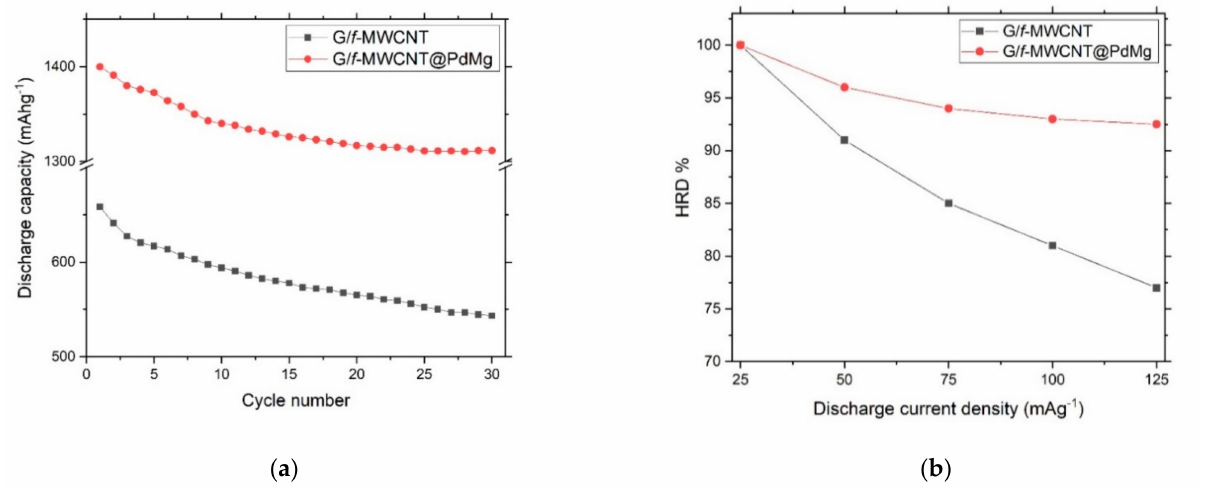
Figure 6. ( a ) Discharge capacities of the G/ f -MWCNT and G/ f -MWCNT@PdMg nanocomposites at a current density of 25 mA/g: G/ f -MWCNT electrode; ( b ) high-rate discharge-ability of the G/ f -MWCNT and G/ f -MWCNT@PdMg